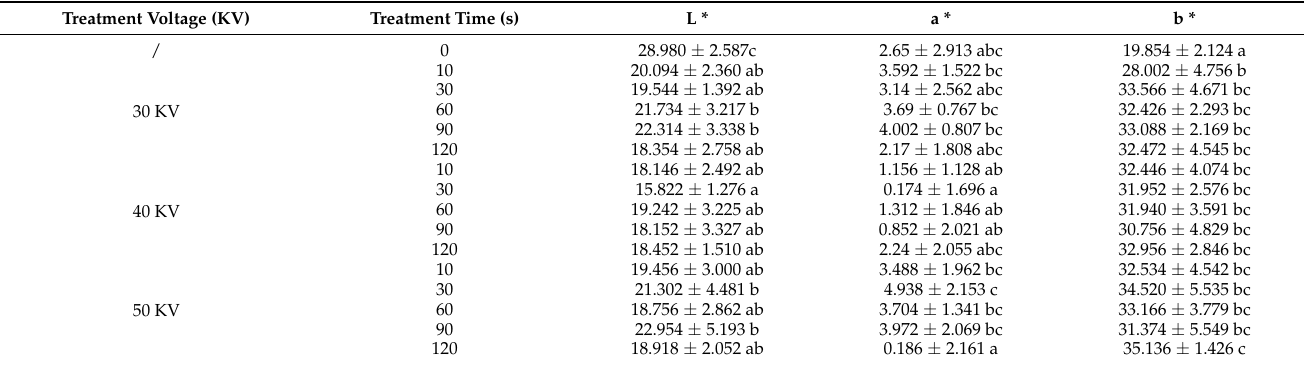
Table 2. Effect of cold plasma treatment on the surface color of